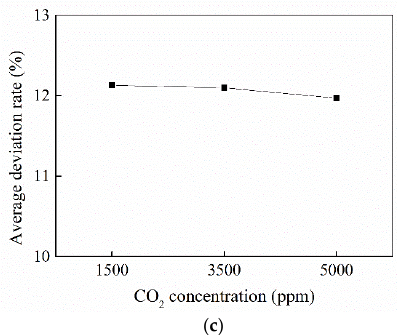
Figure 3. Performance metrics of the RT tests and the speed perception test under different CO 2 conditions. ( a ) Accuracy of the RT tests. ( b ) Response time of the RT tests. ( c ) Average deviation rate of the speed perception test.